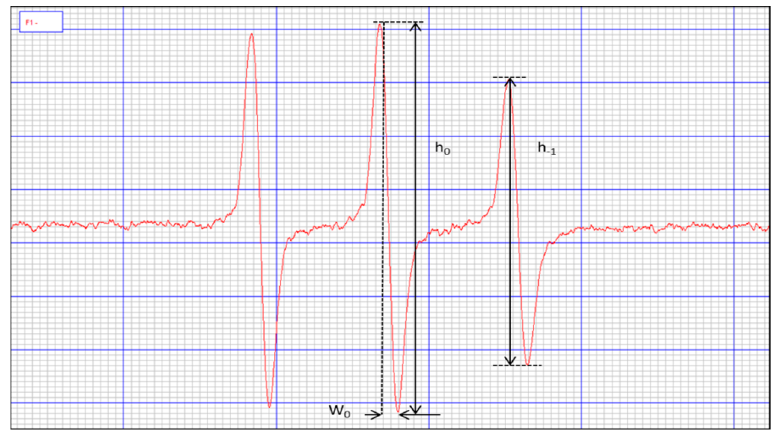
Figure 4. View of the Tempamine marker.